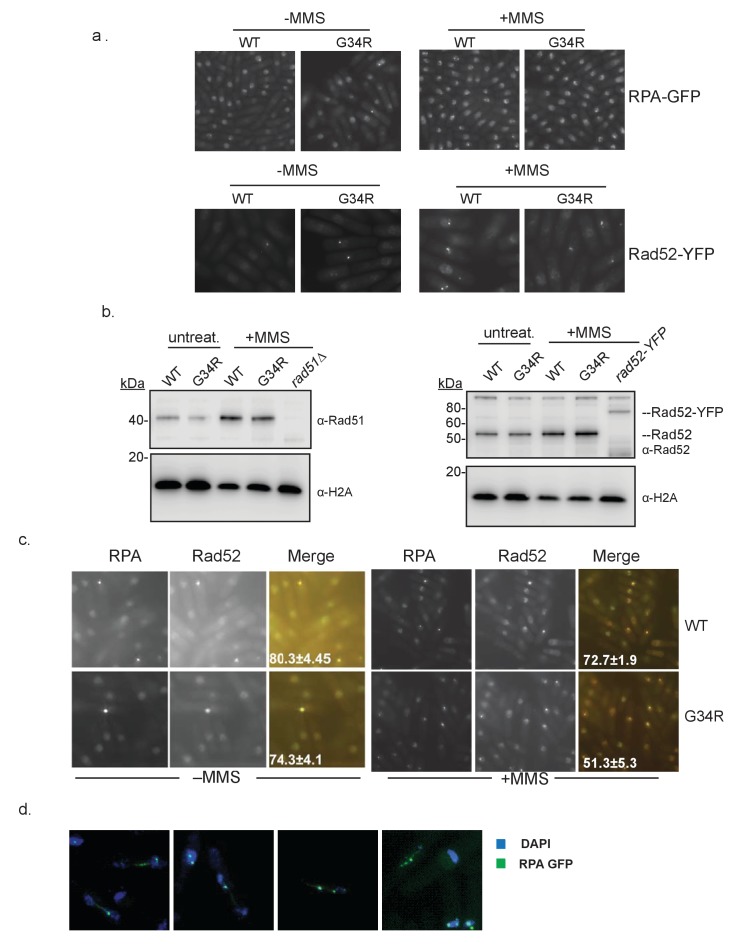
Localization of homologous recombination-directed repair proteins in H3-G34R cells.(a) Representative images showing foci formation of RPA (Rad11-GFP) or Rad52-YFP in either H3-WT or H3-G34R backgrounds. Cells were either treated in the presence (right) or absence (left) of 0.05% MMS for 4 hr prior to imaging. Experiment was repeated twice. (b) Western blot analysis depicting the total levels of Rad51 and Rad52 in either H3-WT or H3-G34R cells before and after treatment with 0.05% MMS for 4 hr. Cells lacking rad51 or containing the rad52-YFP allele serve as antibody-specificity controls. Blots were reprobed for total H2A which serves as a loading control. One example is shown of duplicate experiments. (c) Representative images depicting foci formation and co-localization of RPA (Rad11-GFP) and Rad52-YFP in either H3-WT or H3-G34R backgrounds before (left) or after treatment with 0.05% MMS for 4 hr (right). Errors represent the SEM from two independent experiments. (d) RPA localization during mitosis. cdc10-m17 cells carrying Rad11-GFP (RPA-GFP) in H3-G34R background were arrested in G1 and released at 25°C before fixation. Representative cells from 150 min after release with ultrafine anaphase bridges labeled by RPA-GFP are shown.